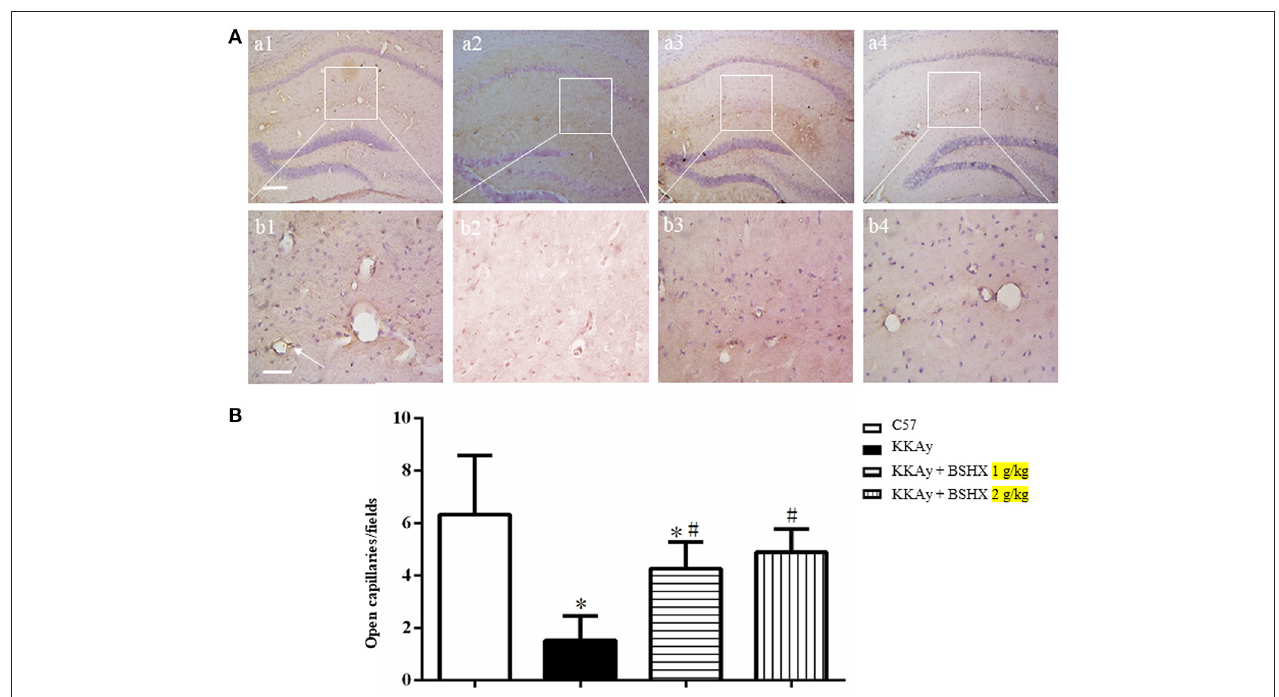
FIGURE 6 | The effect of BSHX on the number of open microvessels in mouse hippocampus. (A) Representative immunohistochemistry images of mouse hippocampus region in different groups. Arrows represent open microvessels. a1: C57 group; a2: KKAy group; a3: KKAy + BSHX 1 g/kg group; a4: KKAy + BSHX 2 g/kg. Bar = 200 µ m. High magnifications of a1–a4 are shown below as b1–b4, respectively. Bar = 50 µ m. (B) Quantitative analysis of CD-31 positive opening microvessels. Data were expressed as mean ± SD ( n = 5). * p < 0.05 vs. C57 group, # p < 0.05 vs. KKAy